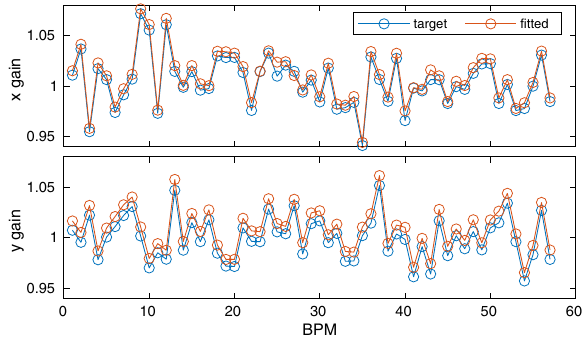
FIG. 6. Comparison of fitted BPM gains and the target